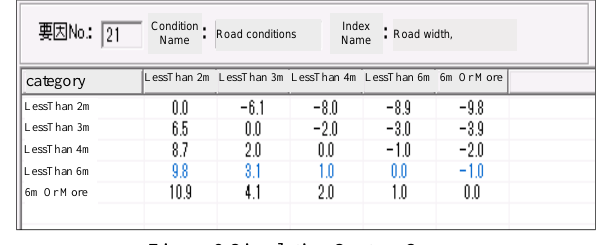
Figure.6 Simulation System Screen